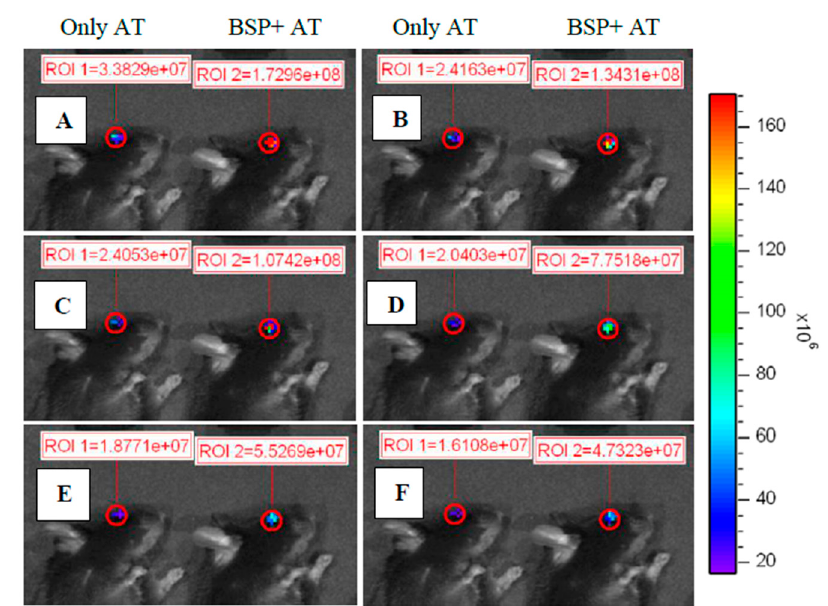
Figure 7. Color photographs showing the ocular retention of the artificial tears mixed with dye (TAMRA) on the ocular surface of mice treated with only artificial tears (AT) and BSP + AT after ( A ) 5-min; ( B ) 10-min; ( C ) 15-min; ( D ) 30-min; ( E ) 45-min and ( F ) 60-min exposure to the artificial tears.